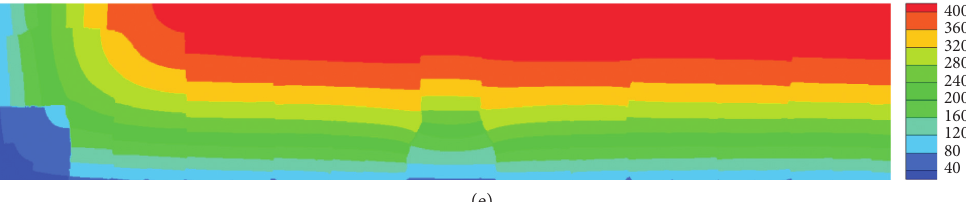
Figure 13: Temperature fields with different material shapes ( t � 1.0s): (a) M